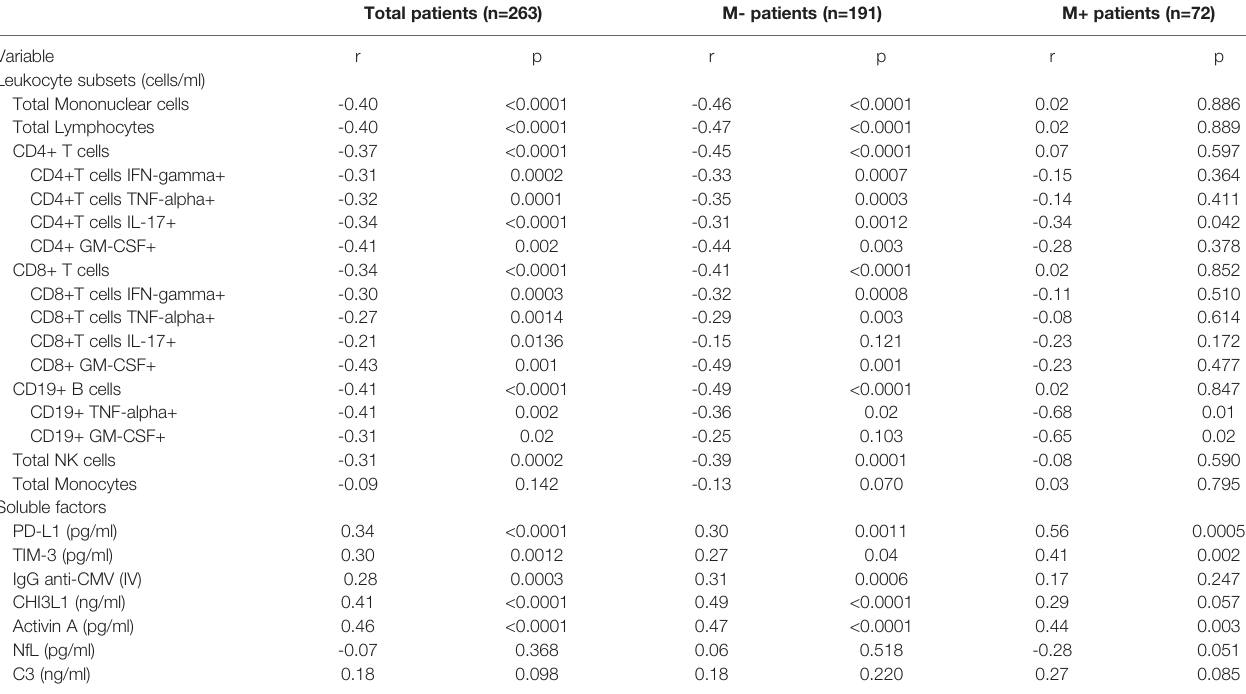
TABLE 2 | Correlations between age and variables related to immune response or axonal damage. Total patients